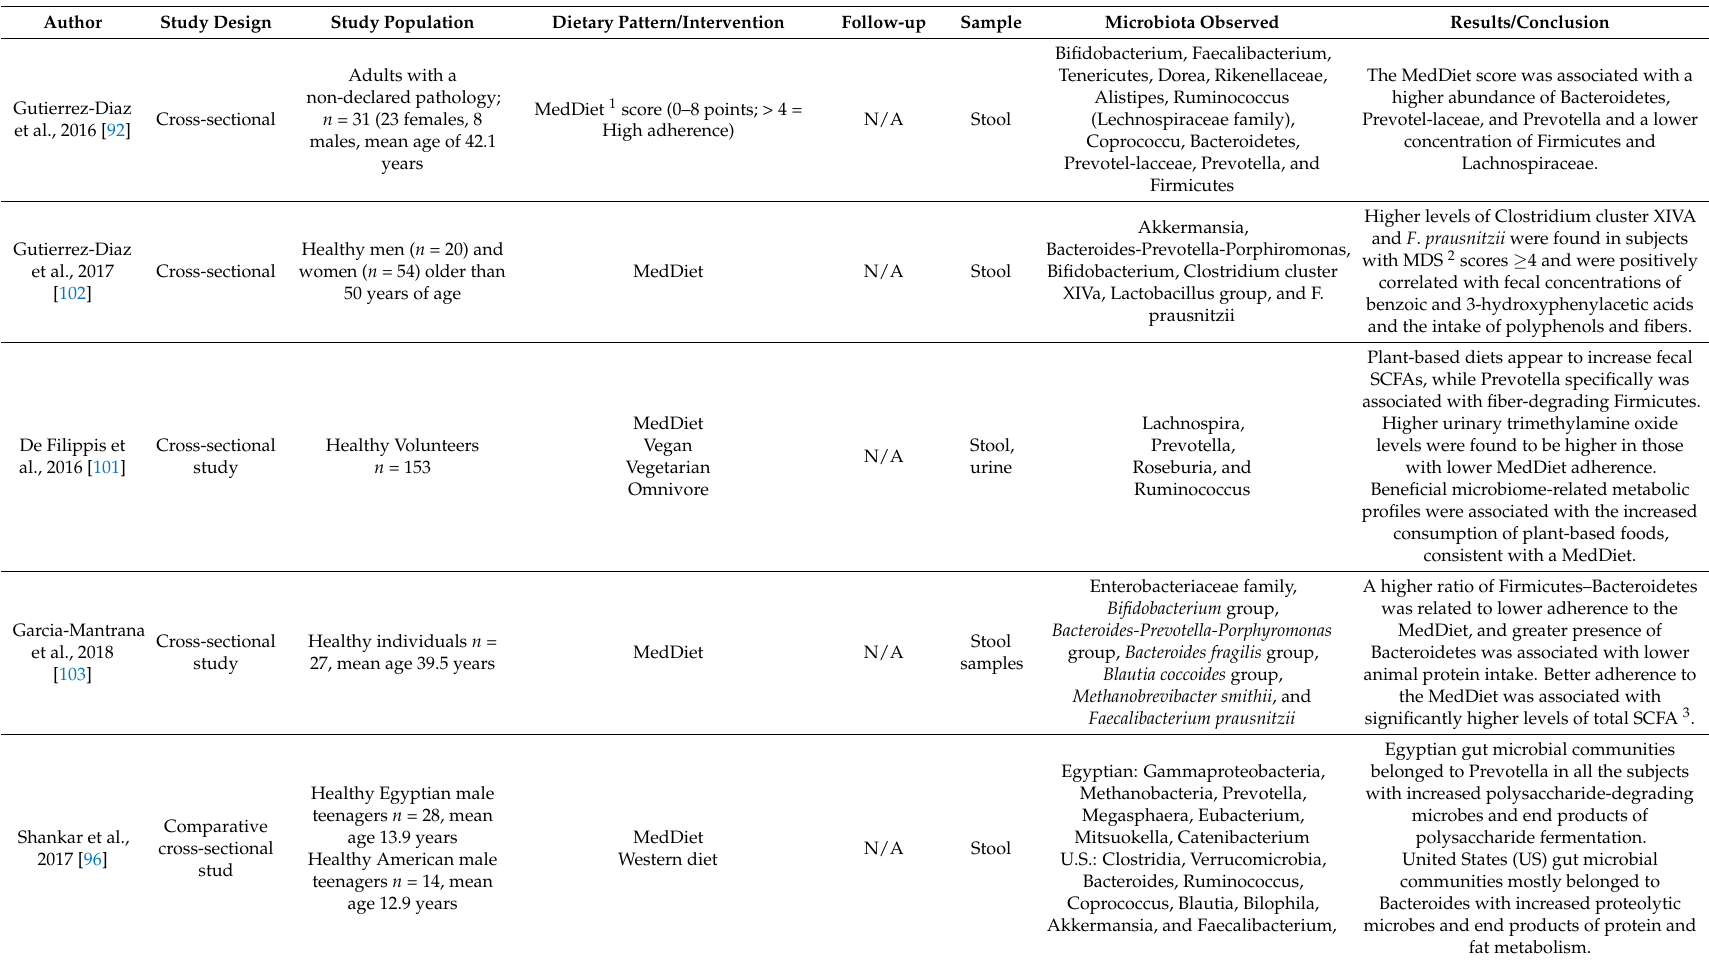
Table 3. Effects of a Mediterranean diet on microbiome